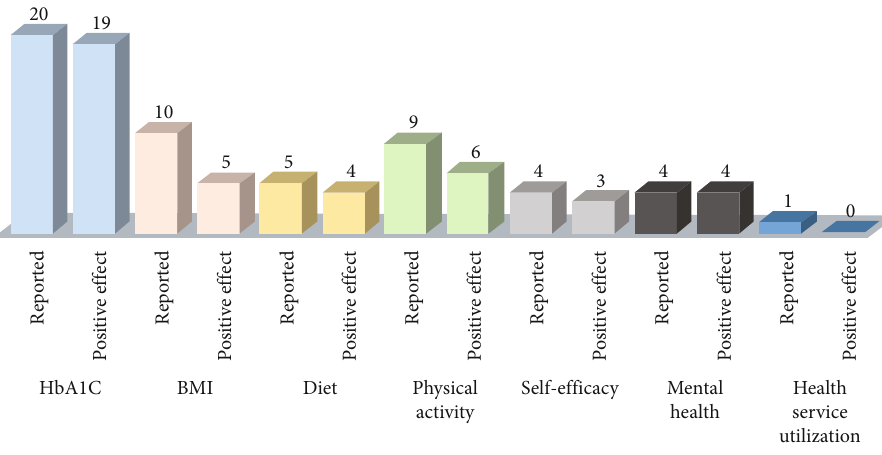
Figure 2: Number of studies reporting on the selected outcome measures and the corresponding number of positive e ff ects on each